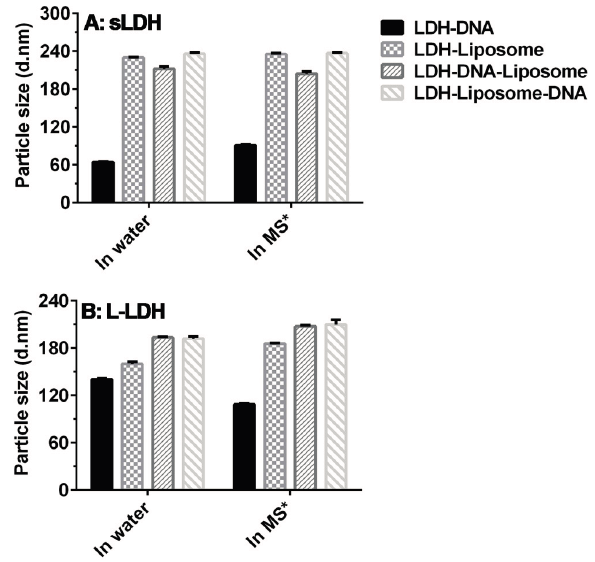
Figure 3. The Z -average particle sizes of LDH NPs and LDH–liposome formulations loaded with dsDNA (dsDNA = 10 µg/mL; the mass ratio LDH:dsDNA = 20:1; EPC:dsDNA = 20:1; * MS = medium + serum, i.e. , complete cell culture